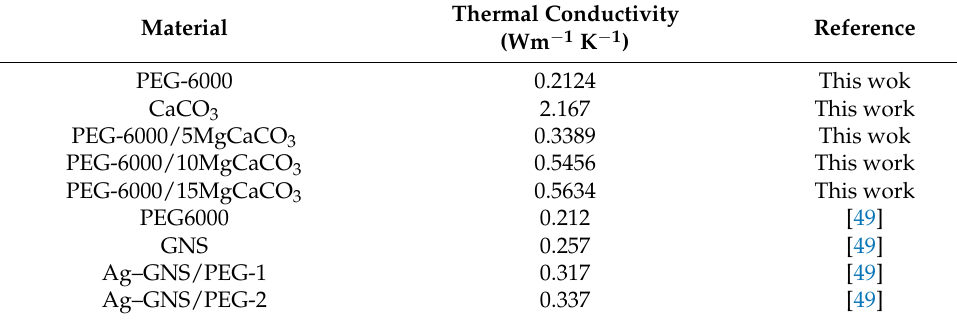
Table 2. Thermal conductivity of pure PEG-6000 and PEG-6000/5MgCaCO 3 , PEG-6000/10 MgCaCO 3 , and PEG-6000/15MgCaCO 3 PCM composites. These values were compared with